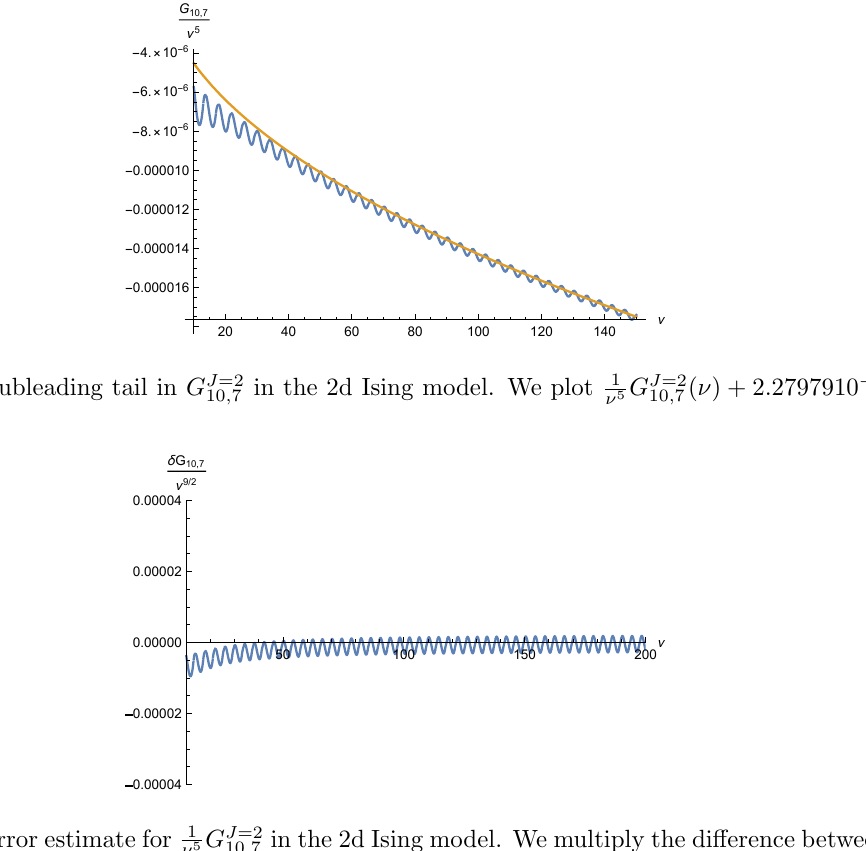
G J =2 in the 2d Ising model. We multiply the di(cid:11)erence between the 10 ; 7 (cid:23) 5 p (cid:23) . Again, we get that the error is consistent